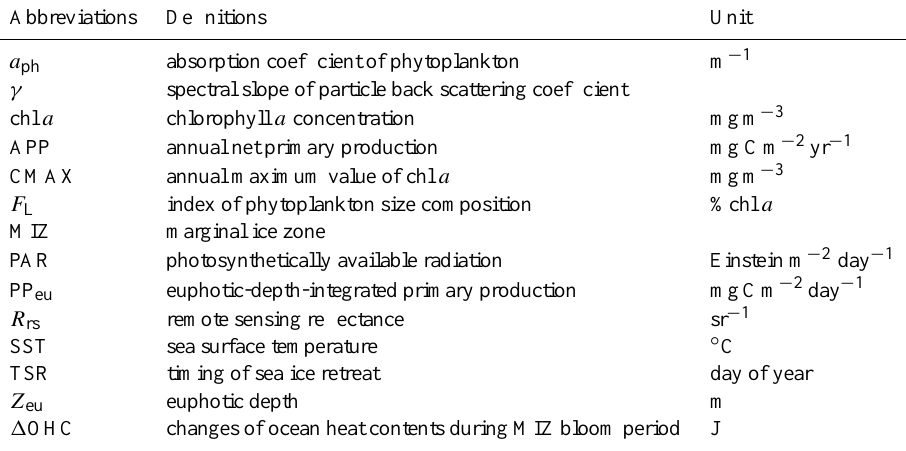
Table 1. List of symbol and